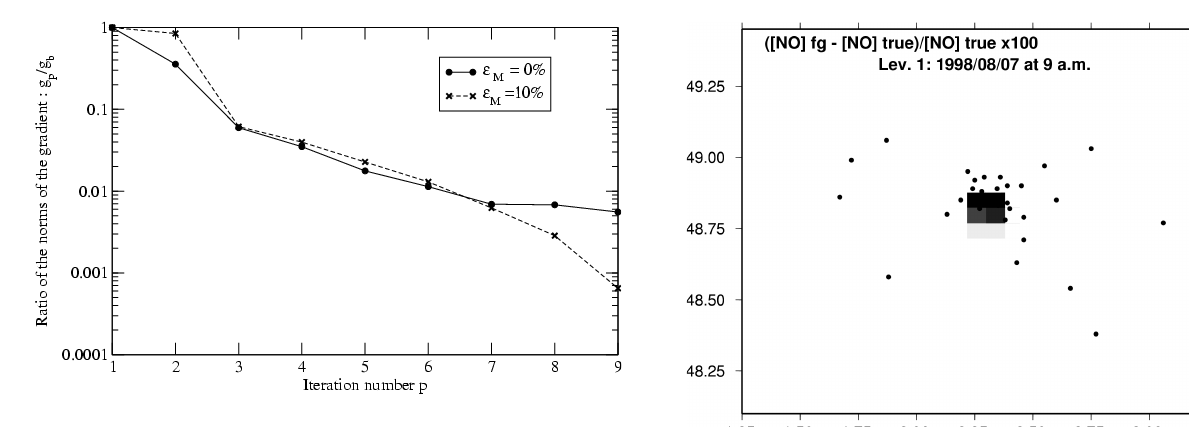
Fig. 6. Differences (ppb) between NO surface concentrations ob- tained with the true emission inventory and with the first-guess in- ventory +100% at 9 a.m.